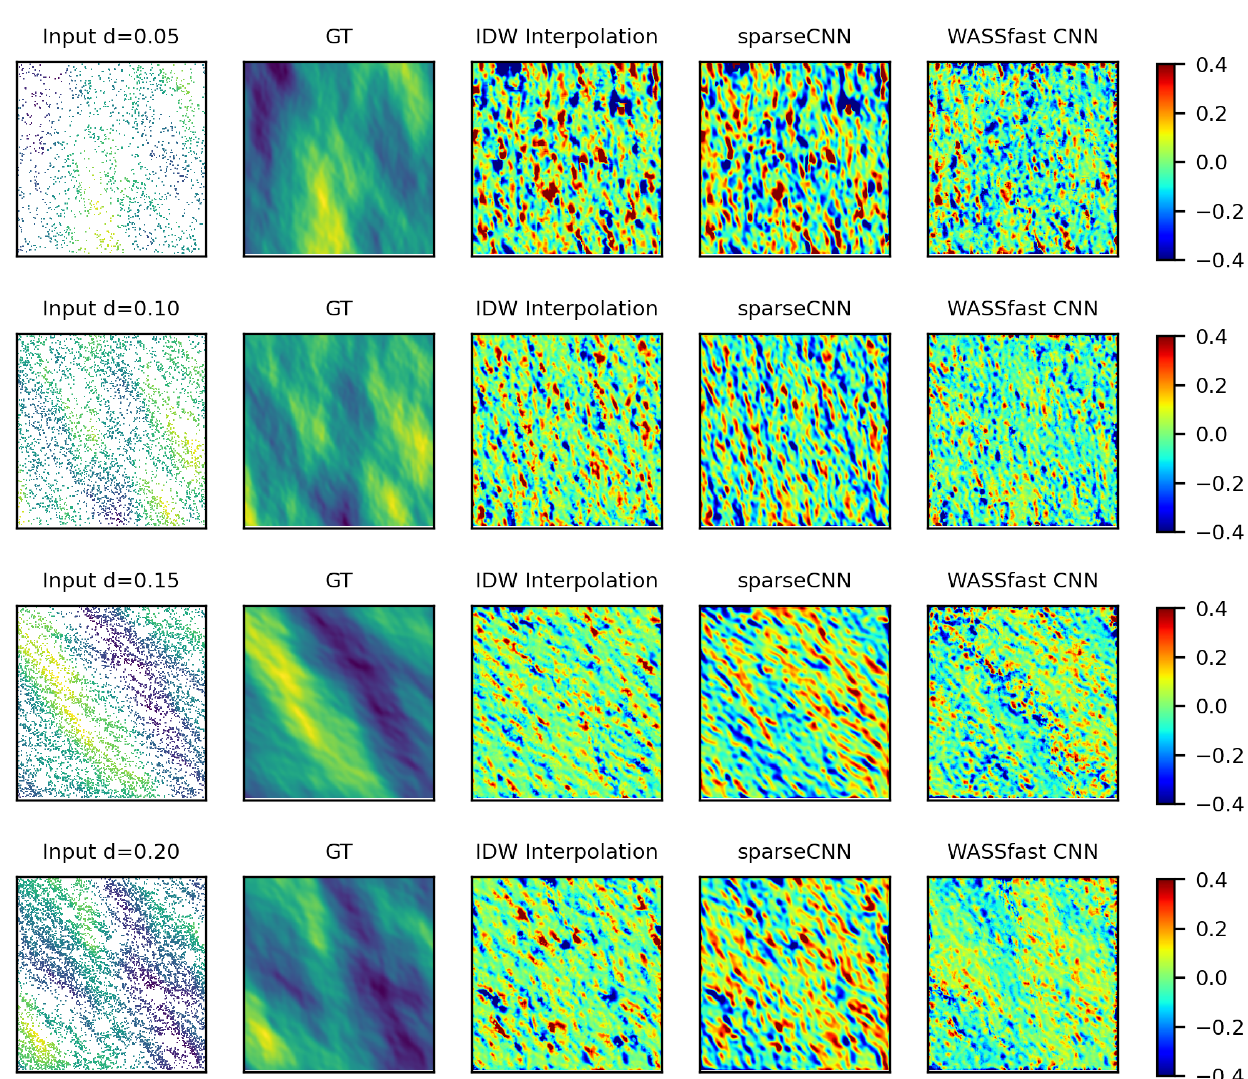
Figure 9. Surface reconstruction errors (in meters) when reconstructing the synthetically generated data. From left to right : sparse input data, ground truth, IDW interpolation, sparseCNN, WASSfast CNN. Each row shows a different scenario with an increasing